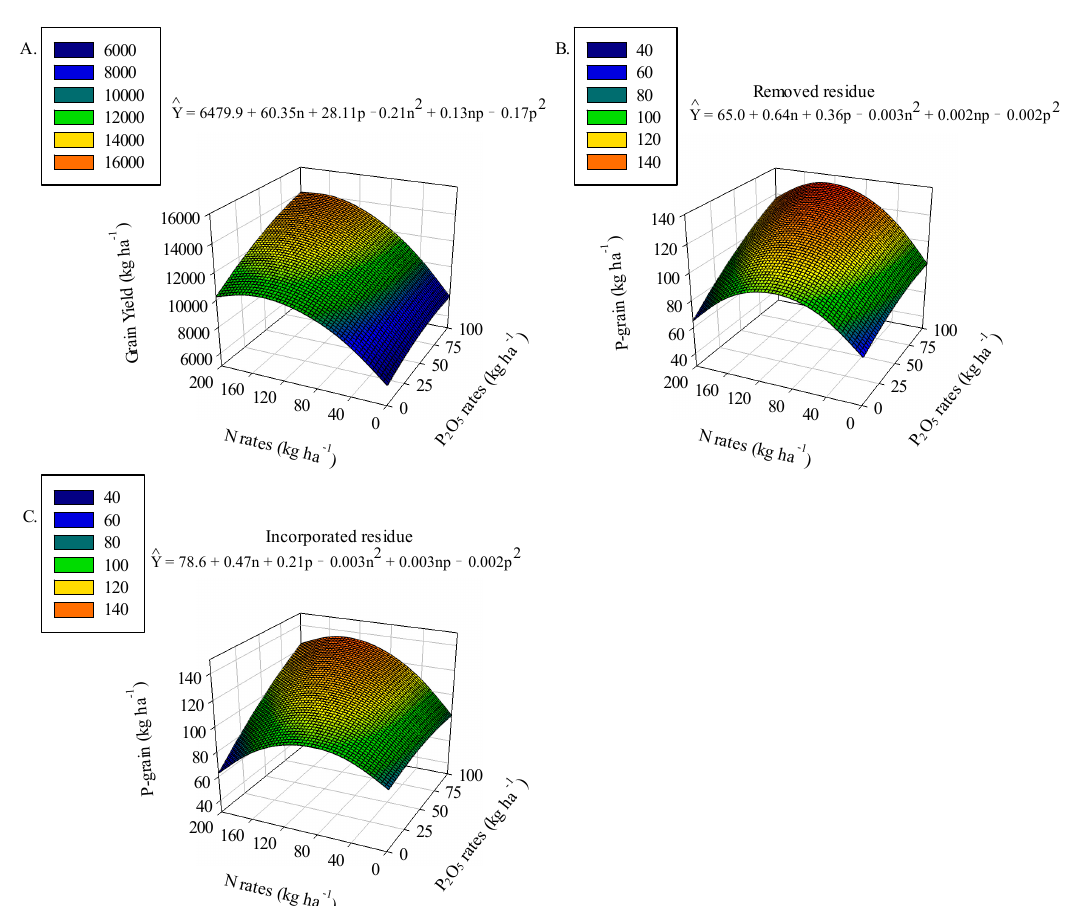
Figure 4. Grain yield ( A ), P-grain with removed ( B ), and P-grain with incorporated residue management ( C ) in 2015 as a function of N and P 2 O 5 rates.